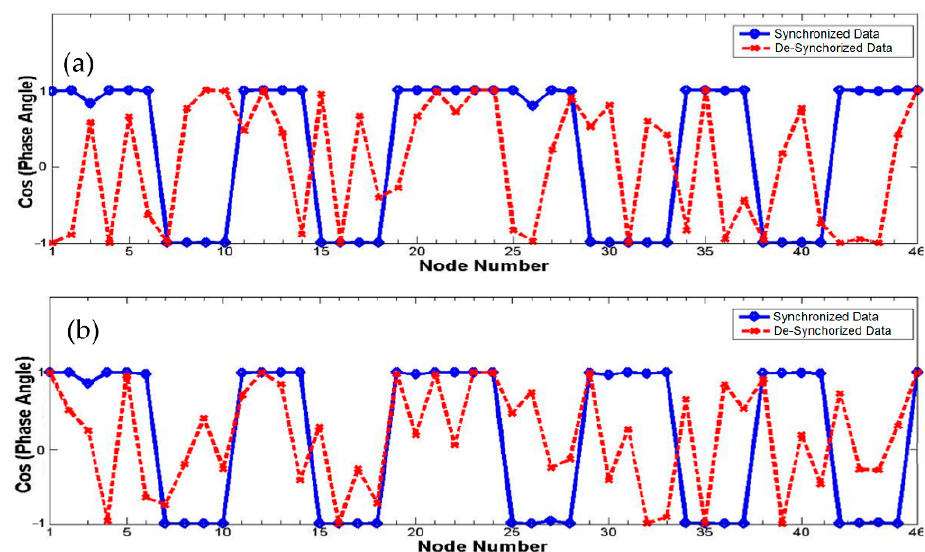
Figure 6. Cosine of phase angles as a function of nodes—first mode ( a ) and second mode ( b ). Varying the time lag at each node between − 2 and +2 s and determining the phase angle at each node produces a sinusoidal curve for phase angle as a function of time lag (PATL) for all modes. The crests and troughs in these plots represent possible solutions (time lags with phase angles equal to 0 or 180 degrees). The first plot in Figure 7 shows the cosine of the phase angle as a function of time lag for the first three modes of node #2. The correct time lag for the synchronized data should be 0 s since the data do not have any time lag; hence, the PATLs of all three modes can be seen coinciding at 0 s, indicated by the thick vertical line. The second plot in Figure 7 shows the PATLs for the same modes and node for de-synchronized dataset. The correct time lag can be readily identified to be − 1.80 s as indicated by the thick green vertical line. Similarly, the time lags for all the nodes can be found, which when applied to data from each setup essentially synchronizes the desynchronized dataset.